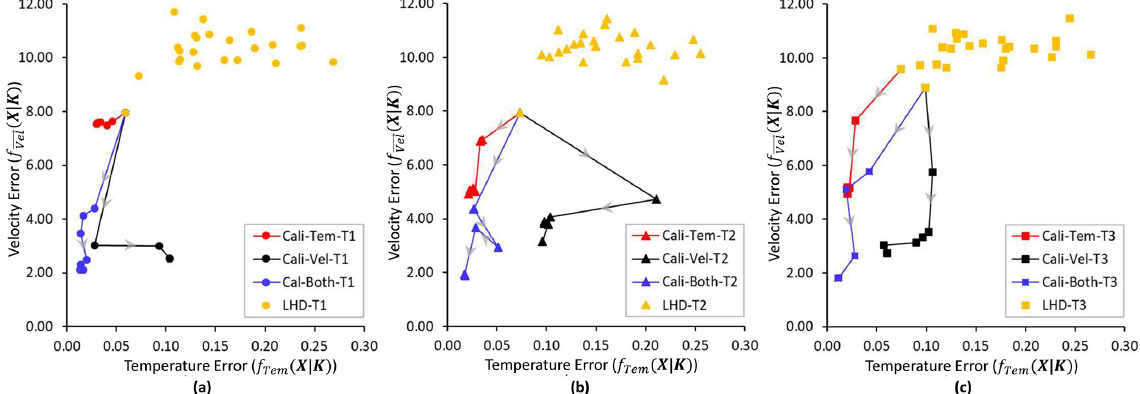
Figure 6. Calibration progress plot of the best solution found (in terms of objective function value) during optimization search by PODS when calibrating to temperature only (Cali-Tem), calibrating to velocity only (Cali-Vel), and calibrating to both temperature and velocity (Cali-Both). Three random trials (i.e., T1, T2, and T3) are plotted in (a) – (c) . Lower velocity and temperature error are better. The yellow markers are evaluation points in the initial experiment design using LHD. Besides solutions in LHD, only the best solution in each of the optimization iterations is plotted (i.e., markers joined by lines). The line links the best previous solution in one iteration to the best solution in next iteration. The arrow indicates the direction from the previous solution to the next